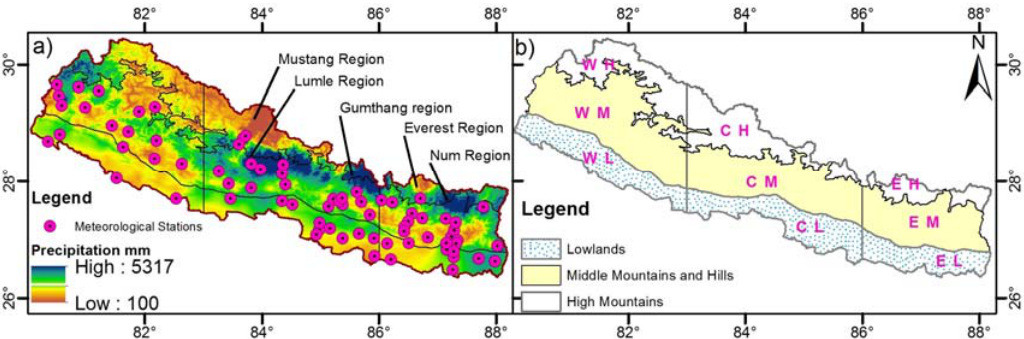
Figure 1. ( a ) Annual precipitation distribution (mm) over Nepal with precipitation pocket areas and dry areas delineated, and the meteorological stations used for the daily extreme analysis overlaid; ( b ) The three broader physiographic zones of Nepal and nine sub-regions (WL—Western Lowlands, WM—Western Middle Mountains and Hills, WH—Western High Mountains, CL—Central Lowlands, CM—Central Middle Mountains and Hills, CH—Central High Mountains, EL—Eastern Lowlands, EM—Eastern Middle Mountains and Hills, EH—Eastern High Mountains).